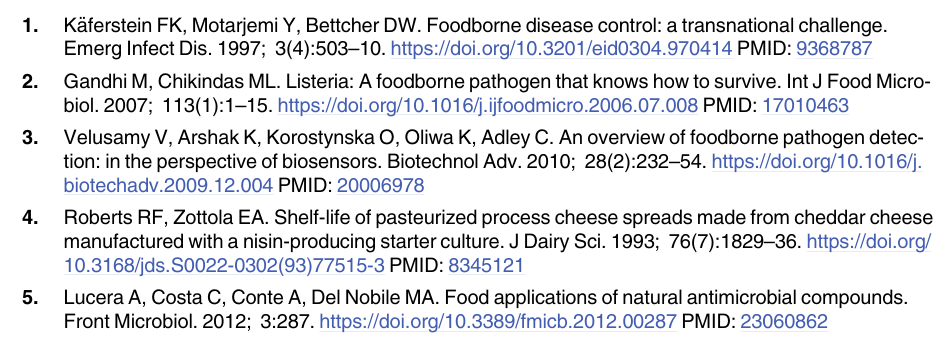
S2 Fig. Schematic representation of the strategies of co-expression of nisA and nisZ genes in L . lactis . S3 Fig. Evaluation of genetic stability of the pMG36e plasmid expressing of nisA and nisRK genes in L . lactis